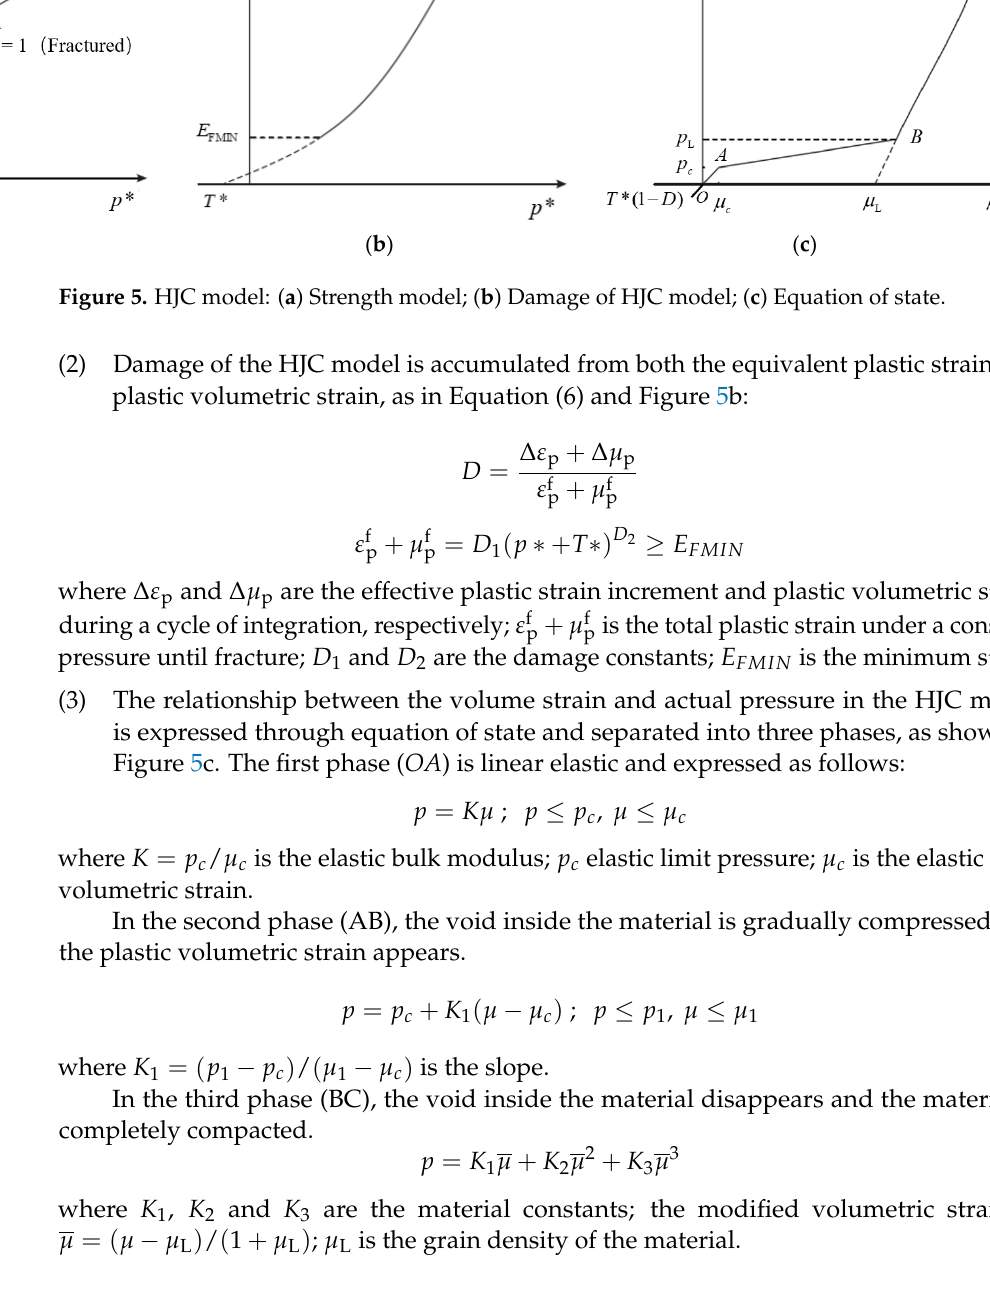
µ = ( µ − µ L ) / ( 1 + µ L ) ; µ L is the grain density of the